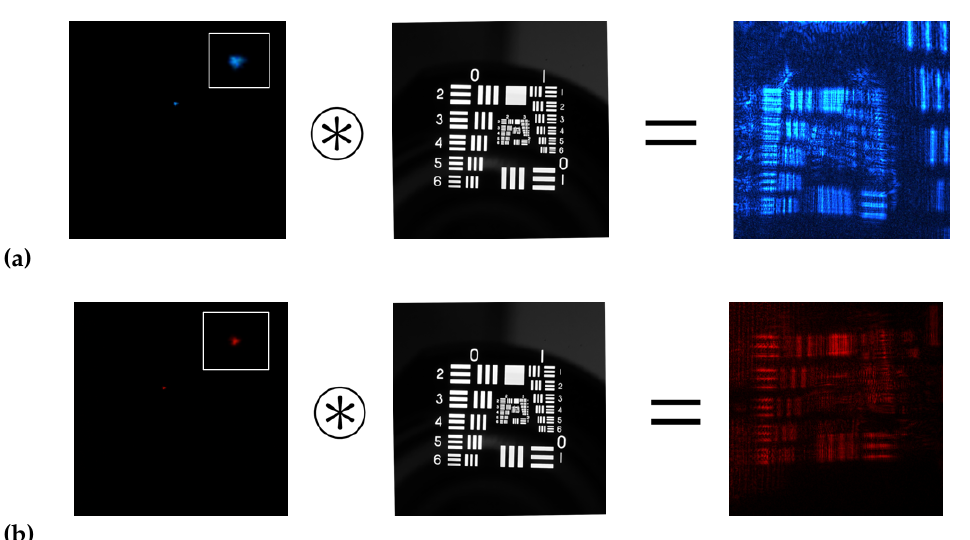
Figure 7. Image obtained with the CCD sensor illuminated at: ( a ) 473 nm, ( b ) 633 nm.